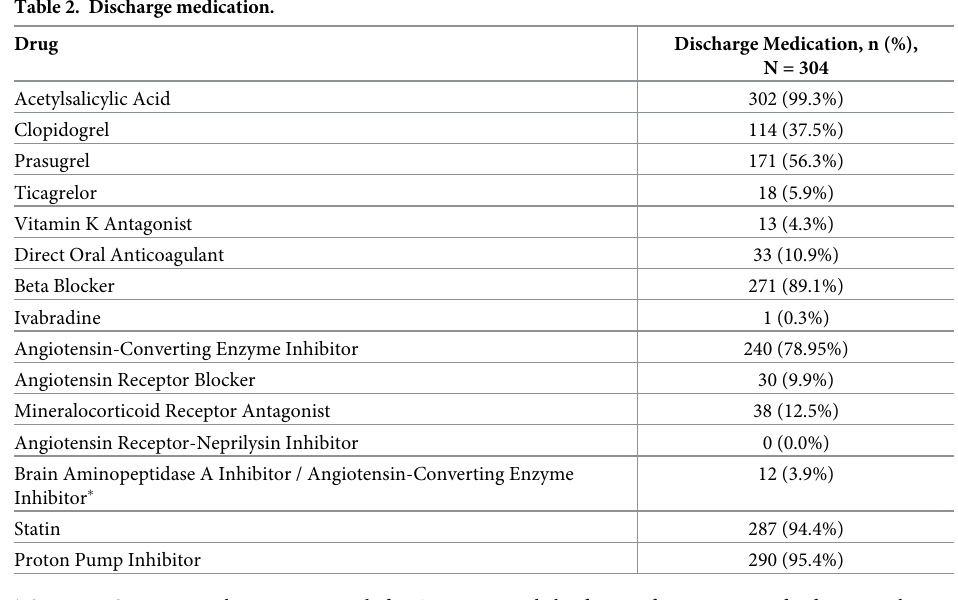
Table 2. Discharge